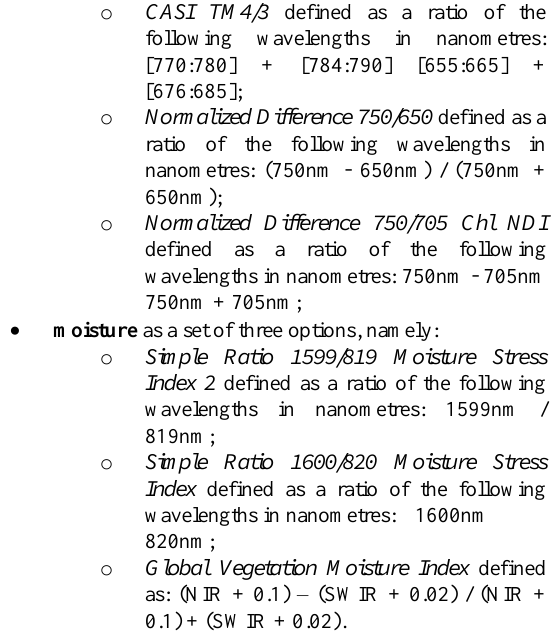
Figure 3. The same area captured by colour photo in visible portion of the spectrum (right) and Normalized Difference Vegetation Index (left) allowing to discover information not directly available within the visible portion of the spectrum (figure adopted from Warren,